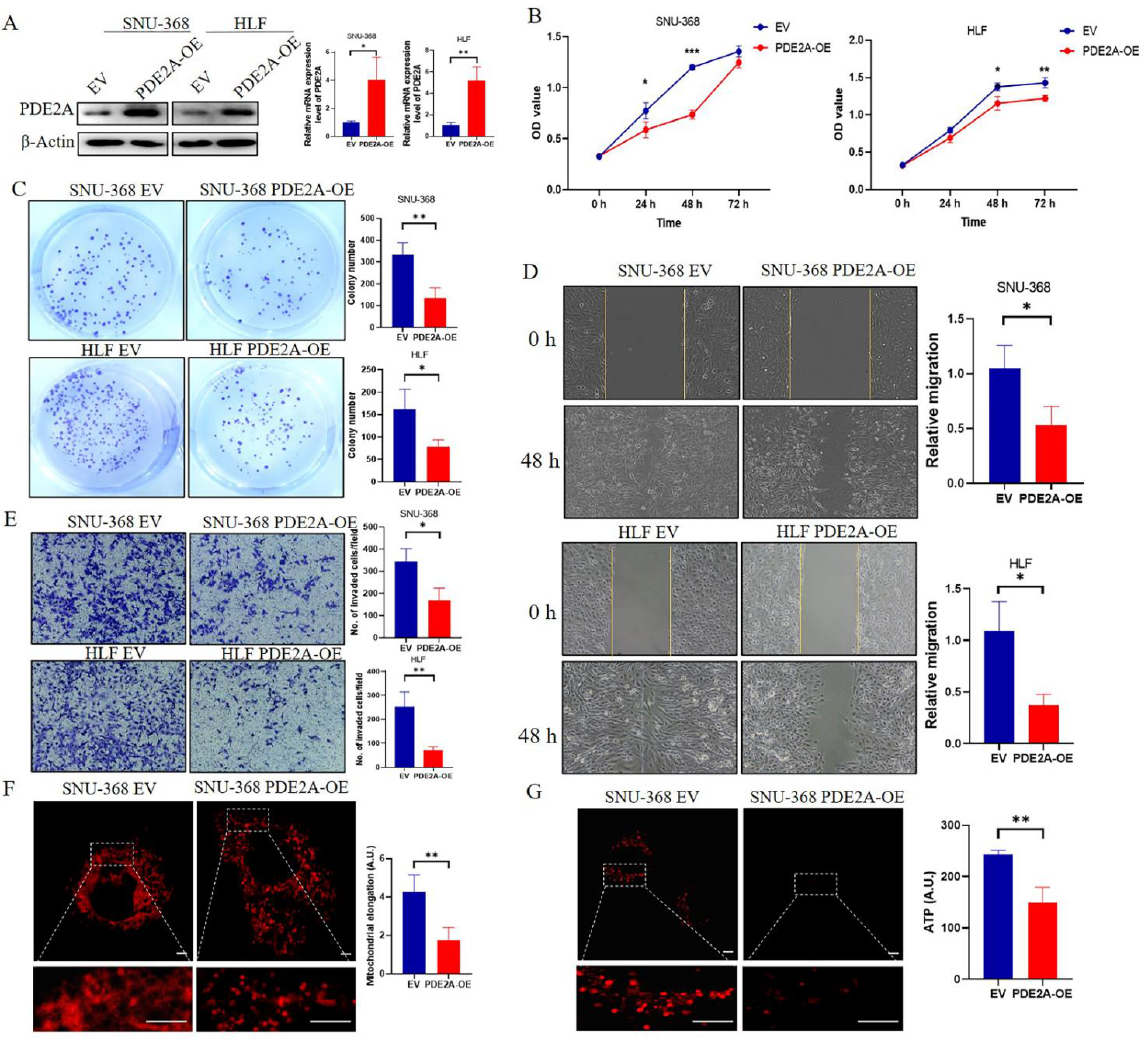
Figure 6. Overexpression of PDE2A inhibits the proliferation, colony formation, migration, and invasion of HCC cell lines by regulating the mitochondrial morphology and ATP content. ( A ) Western blot and RT-qPCR analysis for the protein and mRNA level in HCC cell lines SNU-368 and HLF under PDE2A-overexpressed treatment and empty vector (EV) as control. ( B ) Cell proliferation as- say evaluated by MTS in HCC cell lines SNU − 368 and HLF under PDE2A − overexpressed treatment and EV as control. ( C ) Colony formation assay in HCC cell lines SNU − 368 and HLF under PDE2A − overexpressed treatment and EV as control. ( D ) Cell migration ability evaluated by scratch wound healing in HCC cell lines SNU − 368 and HLF under PDE2A − overexpressed treatment and EV as control. ( E ) Cell invasion ability evaluated by Transwell Matrigel invasion assay in HCC cell lines SNU − 368 and HLF under PDE2A − overexpressed treatment and EV as control. ( F ) Mitotracker staining of mitochondrial morphology in SNU − 368 under PDE2A-overexpressed treatment and EV as control. ( G ) ATP probe detection of ATP content in SNU − 368 under PDE2A − overexpressed treat- ment and EV as control. Scale bar = 0 .25 μm. * p < 0.05; ** p < 0.01; *** p < 0.001.